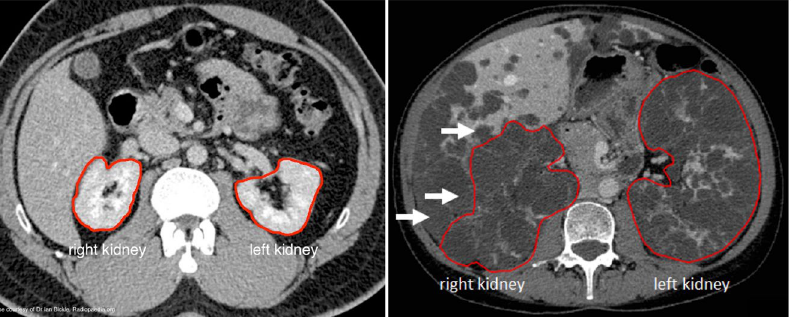
Figure 1. ADPKD Kidney Segmentation. ADPKD Kidneys (right panel) are difficult to segment due to severe morphological changes in comparison to healthy kidneys (left panel). White arrows show adjacent liver cysts exhibiting similar